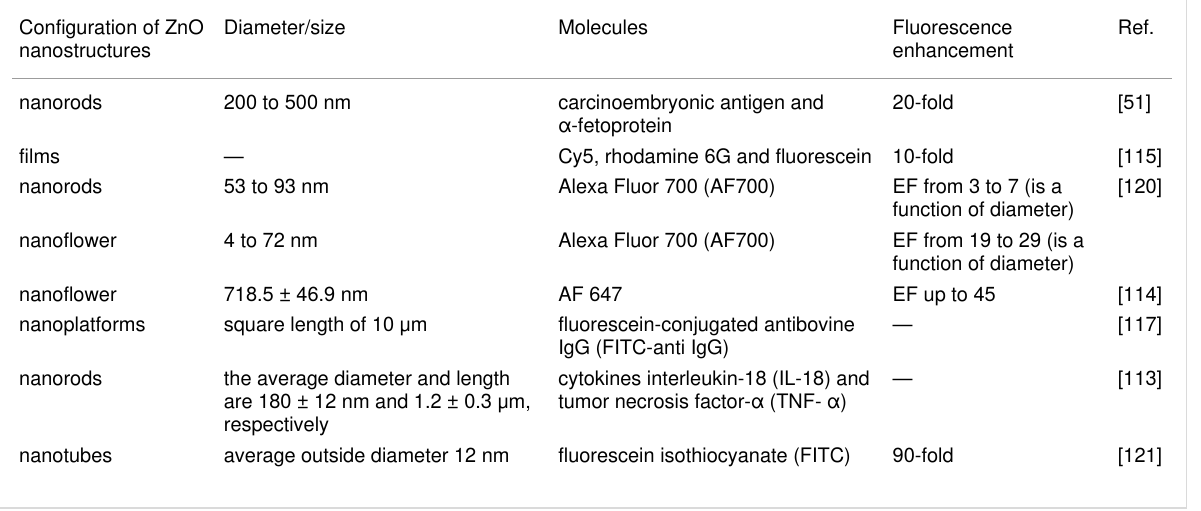
Table 1: Examples of fluorescence enhancement using ZnO nanostructures.